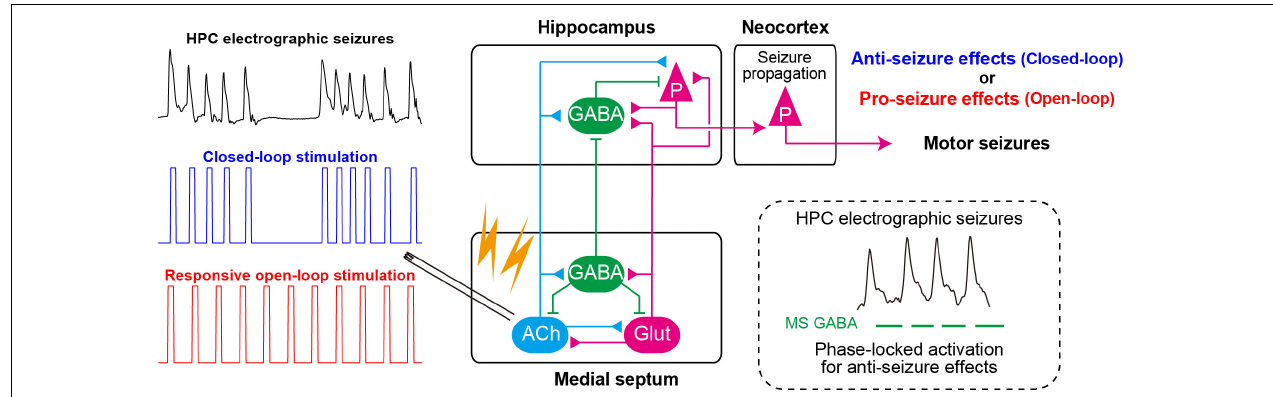
FIGURE 3 | Closed-loop seizure rhythm-driven medial septum (MS) electrical stimulation effectively terminates seizures of HPC origin and suppresses secondary generalization. The precisely timed activation of MS GABAergic neurons may underlie the seizure-terminating effect. In contrast, responsive open-loop MS stimulation does not mitigate (but rather promotes) seizures of HPC origin. ACh, cholinergic neurons; Glut, glutamatergic neurons; HPC, hippocampus (after Takeuchi et al., 2021a).